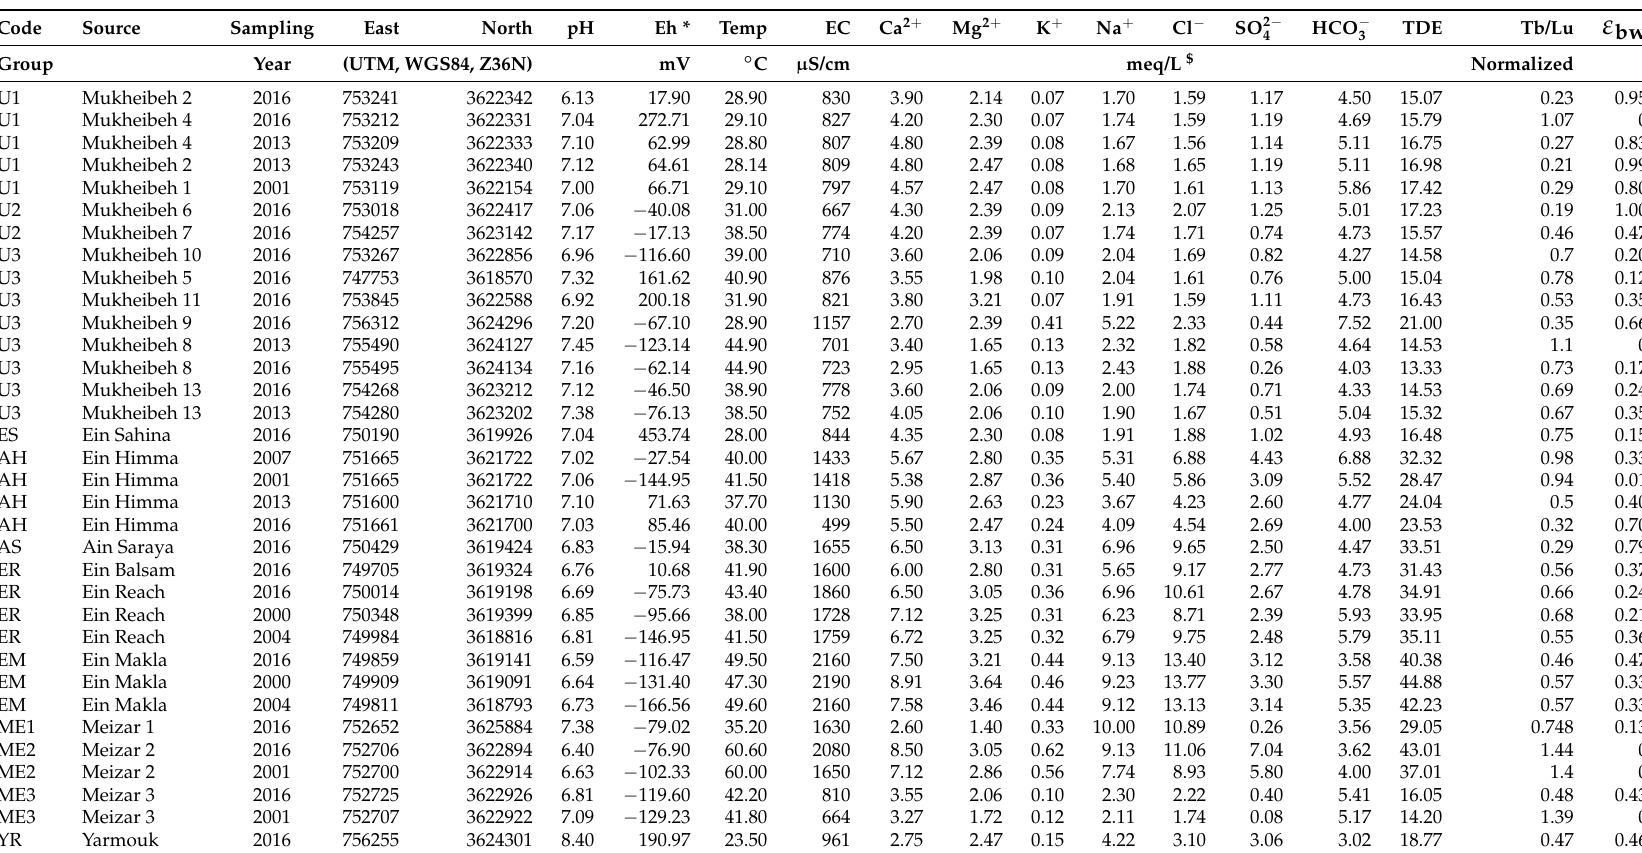
Table 1. Analyses of spring and well waters from the Lower Yarmouk Gorge. Grouping according the geographical and chemical proximity (code). In the two last columns the normalized Tb/Lu ratios and the fraction of basaltic-rock water, ε bw , in mixture with limestone water are given as derived from Figure 4.